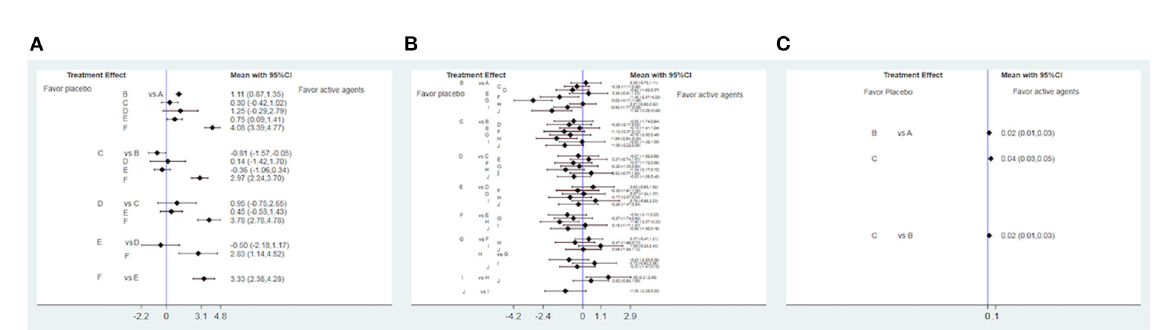
FIGURE2 Forest plot efficacy of hypoglycemic drugs (HD) with placebo (A) Forest plot efficacy of HD with placebo in improving MMSE score. A: placebo, B: intranasal insulin, C: metformin, D: pioglitazone, E: glucagon-like peptide-1 (GLP-1), F: dipeptidyl peptidase 4 inhibitor (DPP-4). (B) Forest plot efficacy of HD with placebo in improving ADAS-Cog score. A: placebo, B: metformin, C: pioglitazone, D: glucagon-like peptide-1, E: rosiglitazone 2mg, F: rosiglitazone 4mg, G: rosiglitazone 10mg, H: rosiglitazone 8mg, I: intranasal insulin 20 IU, J: intranasal insulin 40 IU. (C) Forest plot efficacy of HD with placebo in improving ADCS-ADL scale score. A: placebo, B: intranasal insulin 20 IU, C: intranasal insulin 40